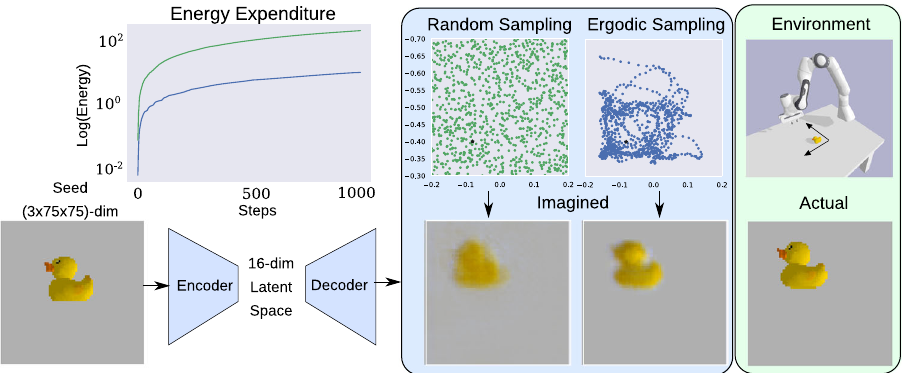
Fig. 3 RGB camera model learning. We compare the predicted measurement generated from the learned 3-channel RGB camera model. Using a seed image, we show the reconstruction of the visual camera fi eld estimate near the object interest, using a CVAE with active learning using random sampling, and the proposed ergodic sampling strategy. Despite no a priori information about the object's location or measurement model, as time evolves, ergodic sampling spends signi fi cantly more time exploring the region around the object in the environment. However, unlike the near- fi eld electrosensory model, the camera characteristics generates exploration further away from the object, where the object appears in the periphery of the camera view, instead of remaining directly over the object. The ergodic sampling approach (shown in blue) requires much lower energy expenditure compared to random sampling (shown in green). Furthermore, the ergodic sampling approach results in a signi fi cantly better reconstruction of the predicted sensor observation, better capturing the object's characteristics (i.e, shape, color) and the characteristics of the sensor-environment interactions (i.e., camera lighting). More detail can be found in the Supplementary